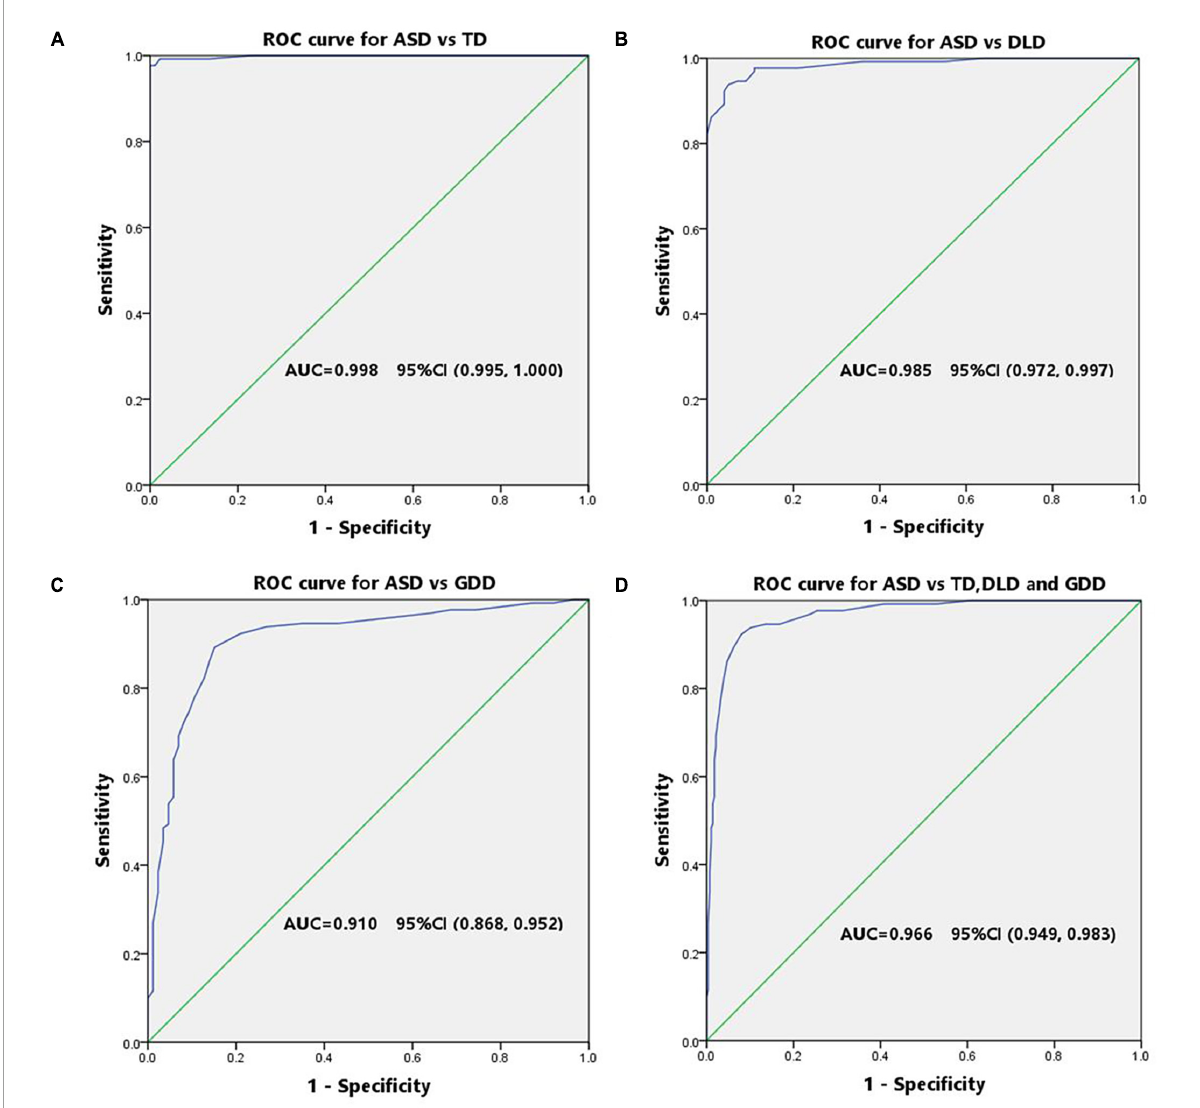
FIGURE3 ROC curve of the communication warning behavior for screening ASD. (A) Receiver operator curve of ASD vs. TD. (B) Receiver operator curve of ASD vs. DLD. (C) Receiver operator curve of ASD vs. GDD. (D) Receiver operator curve of ASD vs. the combination of DLD and GDD.